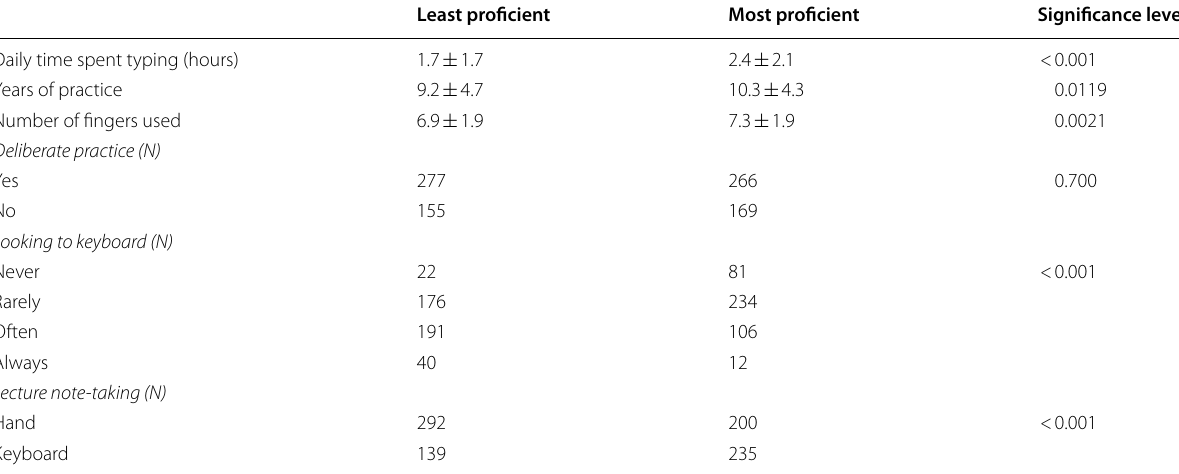
Values are either counts of participants (N) or averages and standard deviations across participants